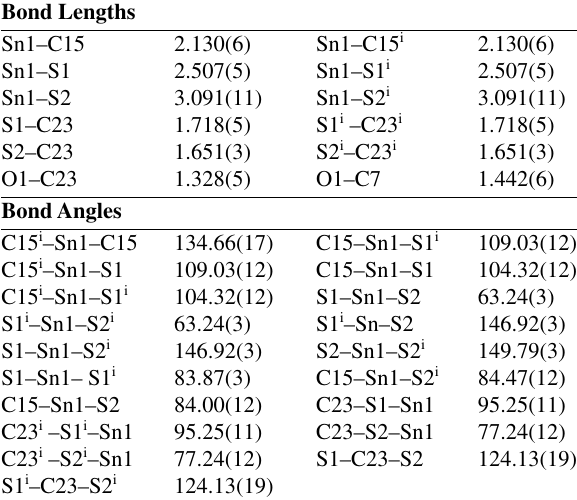
Table 3. Selected bond lengths (Å) and bond angles (°) for the complex [ ( n -Bu)